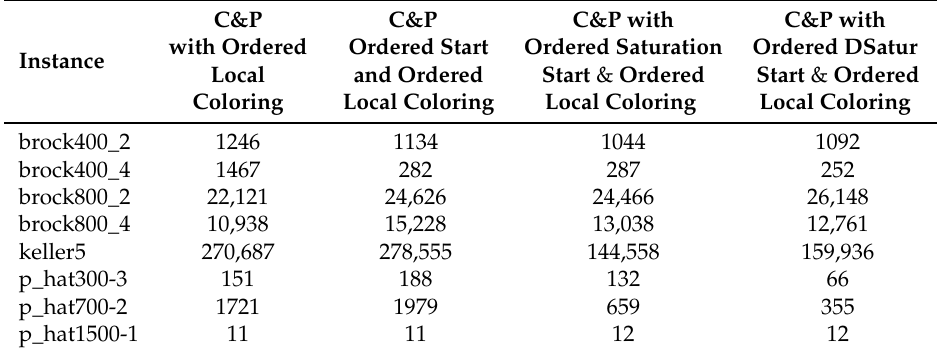
Table 2. Comparison of run times (in seconds) for four improved exact algorithms for the maximum clique problem using ordering. The algorithms in the second and third columns are variations of those in columns 3 and 5 of Table 1 using ordering. The fourth and fifth columns are variations of the third column using saturation or DSatur (Degree of Saturation) start,